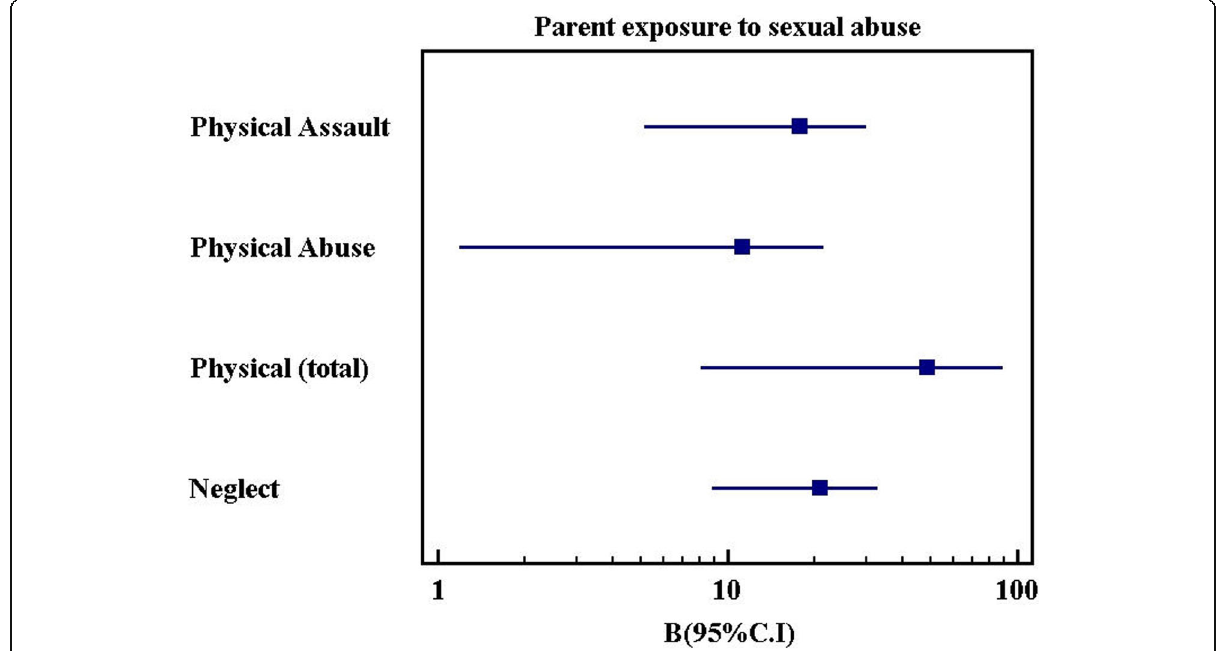
Fig. 4 Univariate linear regression for sexual abuse experienced by parents when they were children affecting their parenting behaviors with their own